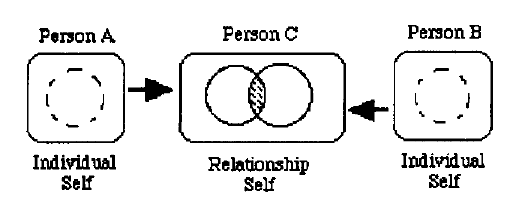
Figure 1: Attachment (White, 1997,